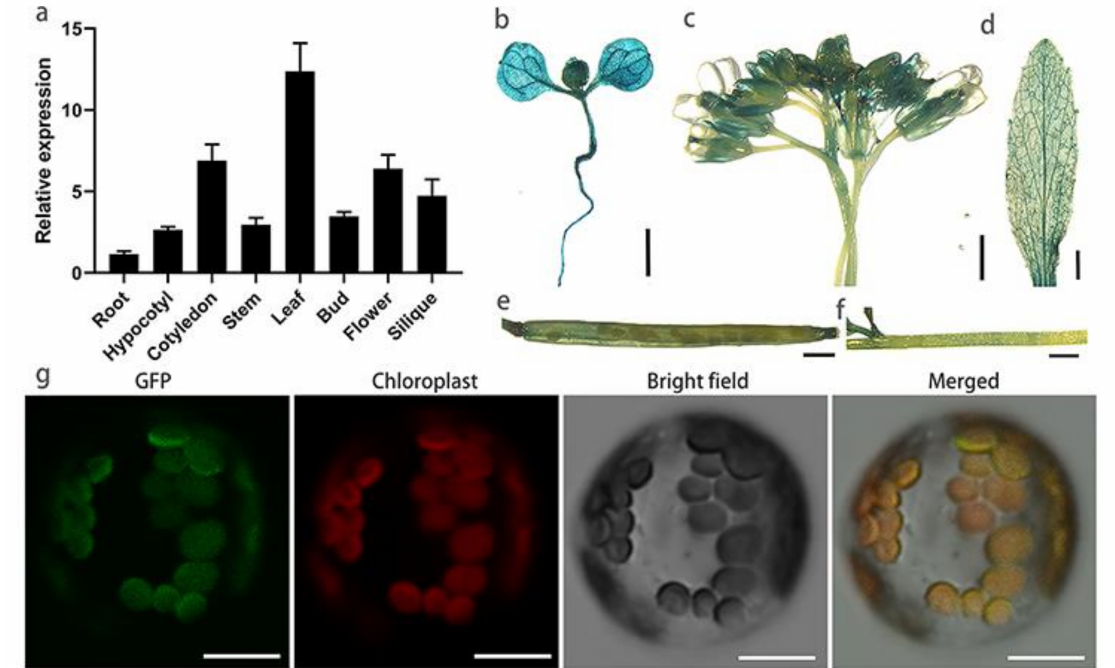
Figure 4. Subcellular localization and expression pattern of BnaC06.FtsH1 . ( a ) Expression pattern of BnaC06.FtsH1 detected by qRT-PCR in the hypocotyls, roots, stems, cotyledons, leaves, flower buds, siliques, and flowers of the Brassica napus cultivar Westar, using the expression of BnaENTH as a reference. Values are expressed as average ± SD (n = 3). ( b – f ) GUS staining analysis of BnaC06.FtsH1 . ( b ) Tender seedling, ( c ) bud, ( d ) leaf, ( e ) silique, and ( f ) stem. ( g ) Subcellular localization of BnaC06.FtsH1 in A. thaliana protoplasts. From left to right: green fluorescence of BnaC06.FtsH1; chloroplast spontaneous red fluorescence; bright-field image; merged image of the first three images. Bars: ( b – f ) 1 mm; ( g ) 12 µ